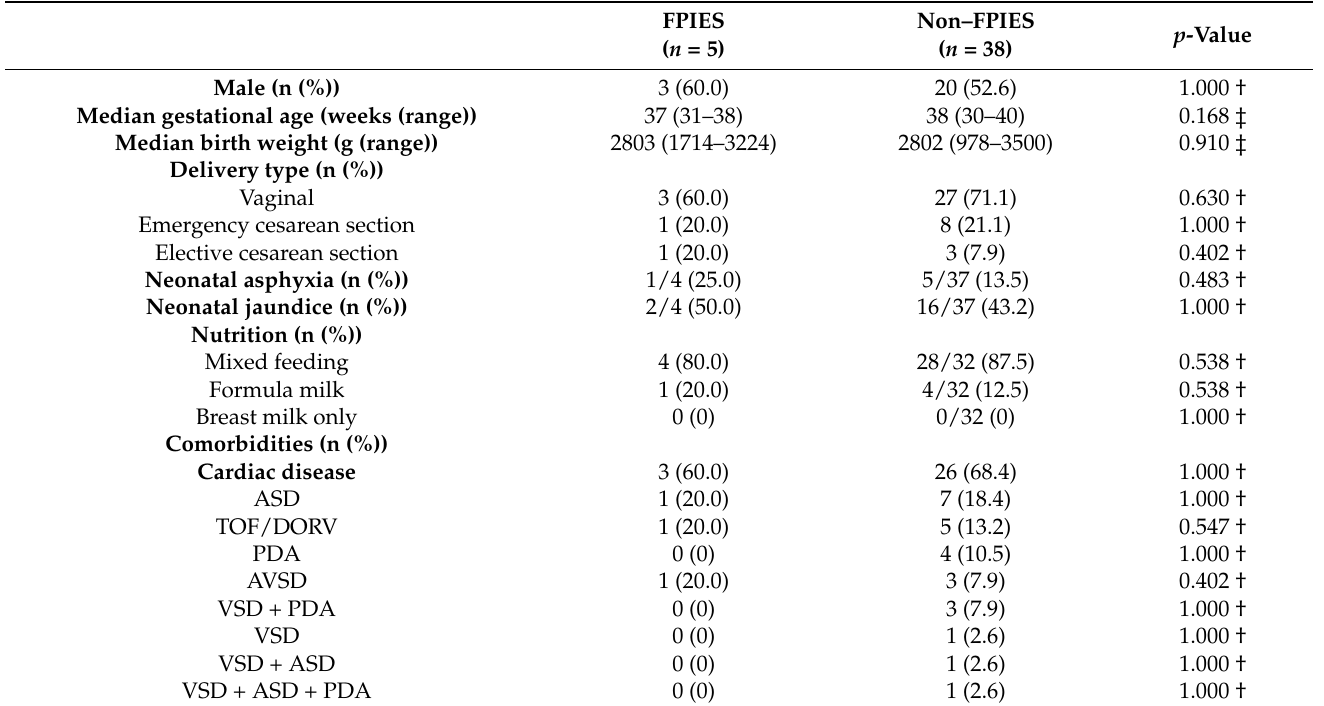
Table 1. Demographic characteristics of children with